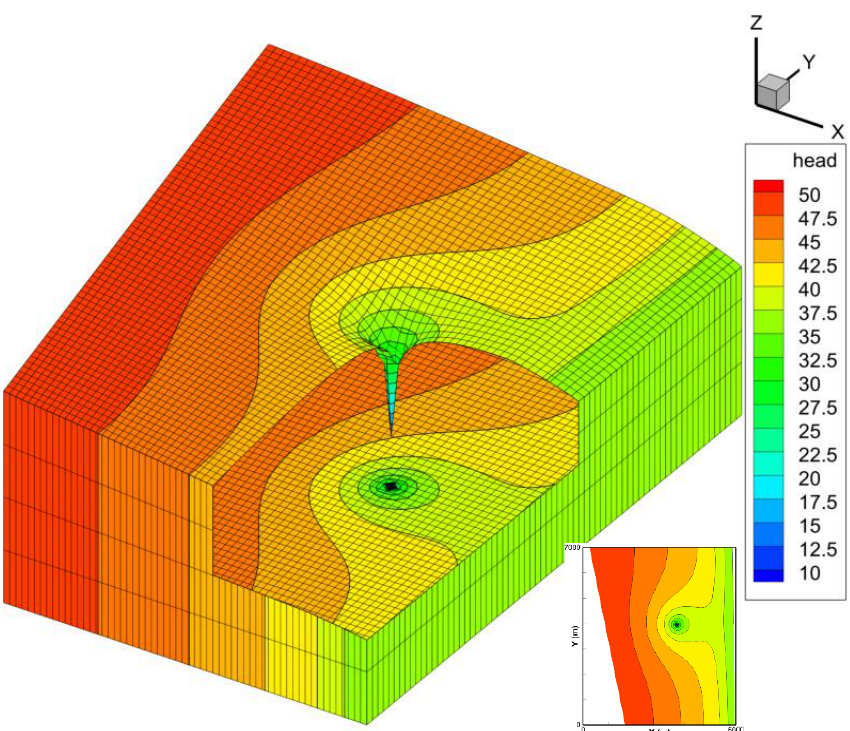
Figure 11. Simulated steady-state water table position and groundwater heads using the adaptive mesh MHFEM technique for the three-dimensional problem. The cutaway view shows the pumping well’s depression cone and the head contours at the aquifer base (vertical aspect ratio = 50).